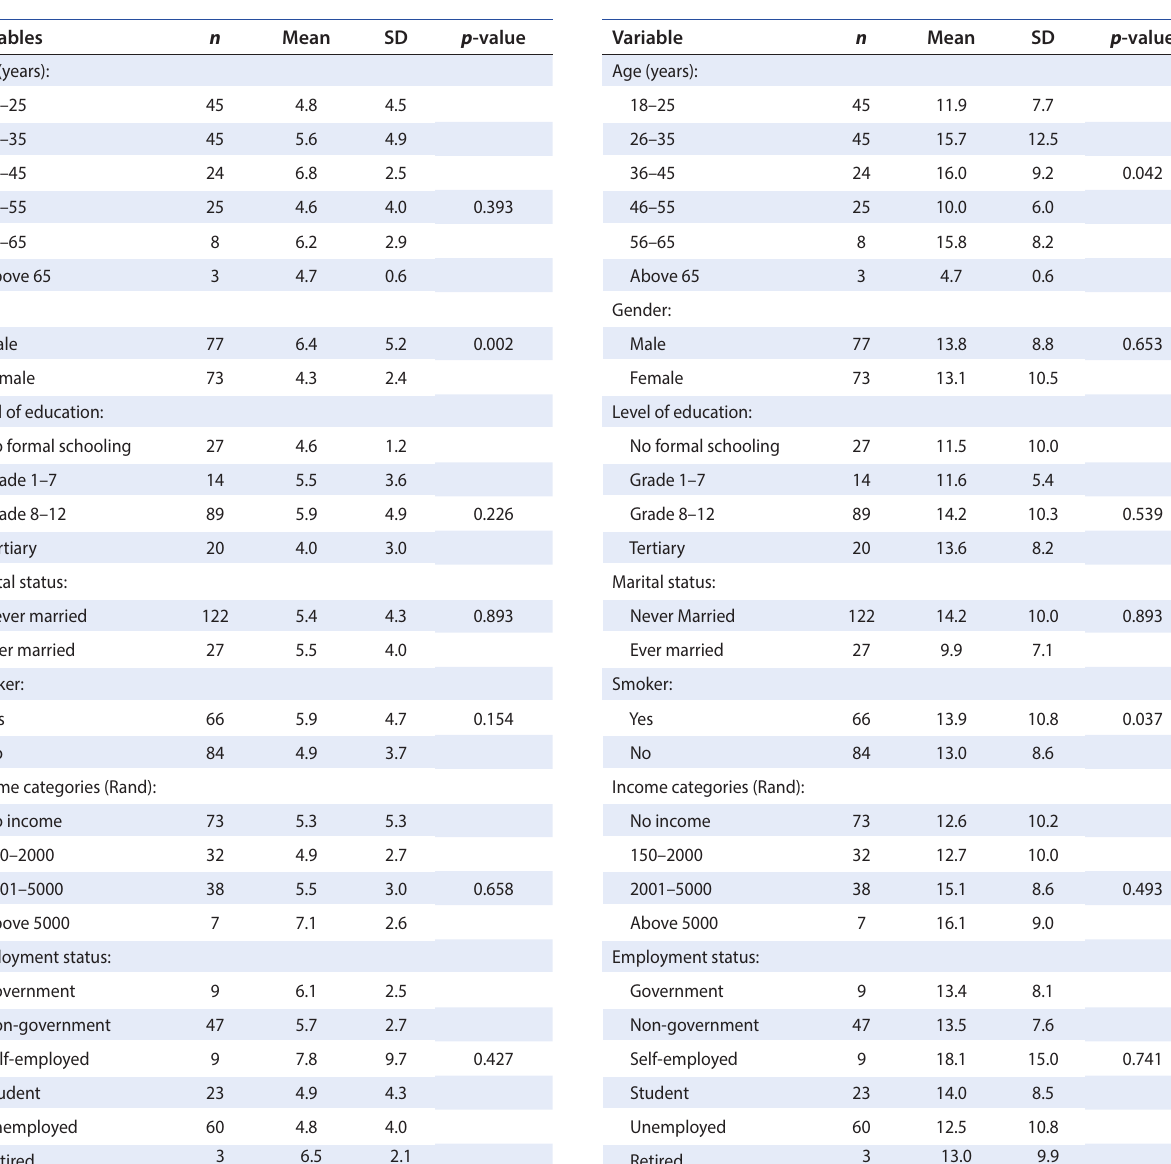
Table 5: Distribution of mean intensity of binge drinking across socio- demographic variables using